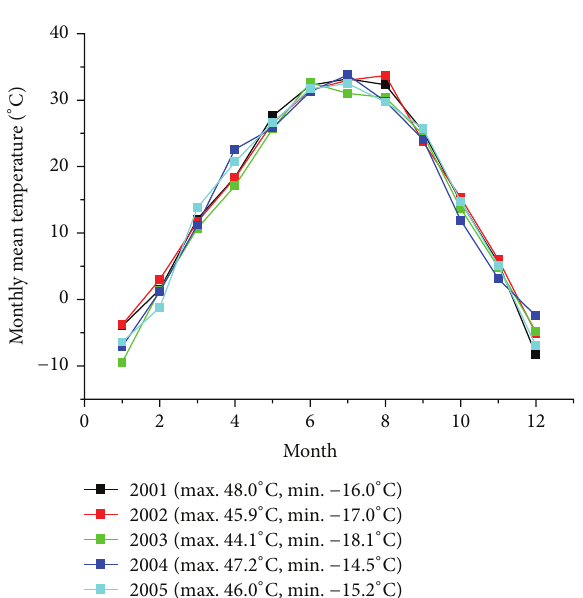
controlled as continuous change in the range of − 20 ∼ 50 ∘ C, and the simulation of the temperature change process of one year was considered to be completed with a freeze-thaw